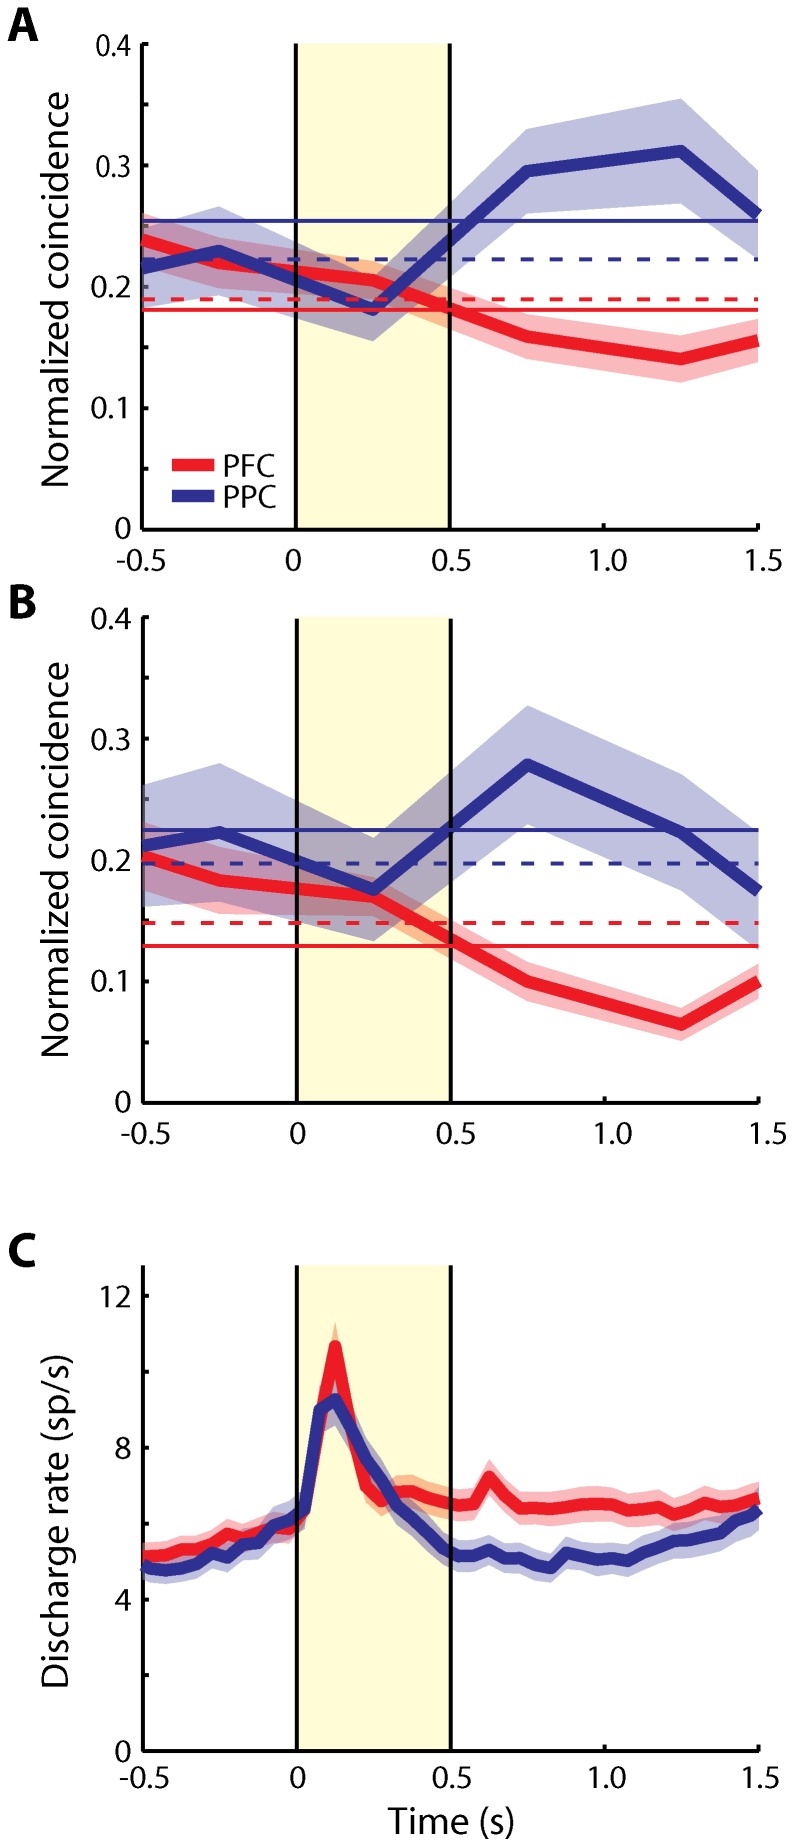
Time course of average effective connectivity.
A) Average normalized coincident spikes occurring within the center bin of PSCCHs are plotted for the dlPFC (red) and the PPC (blue). Horizontal bin size is 500 ms. Samples include all neuron pairs regardless of significance in the delay period (dlPFC: 561 pairs, PPC: 169 pairs). Shaded area along each trace represents one standard error of mean computed across neuron pairs. Yellow shaded area represents the cue presentation period. Each horizontal solid line represents a mean over the period up to the first delay period depicted here (–0.5 s to 1.5 s). Each horizontal dotted line represents a mean over an extended trial period (–0.5 s to 4 s) including the match/non-match period. B) Average normalized coincident spikes occurred within the center bin of PSCCHs using the pairs with significant delay activity are plotted for each area (dlPFC: 265 pairs, PPC: 35 pairs). C) PSTH represents average firing rate of neurons used in the PSCCH analysis, including all neurons from the dlPFC (red, N = 403) and the PPC (blue, N = 178) with/without significant delay activity. The bin size is 50 ms. Shaded area along each trace represents one standard error of mean computed across neurons.